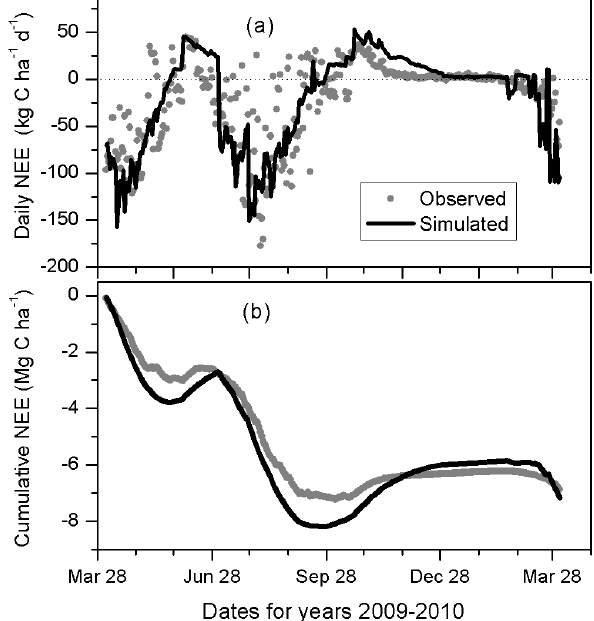
Fig. 2. Simulated and observed aboveground biomass (a) and grain yields (b) of the wheat–maize rotations. Aboveground biomass of wheat–maize rotation was for the WS treatment in 2008–2009 and the U treatment in 2009–2010, with the vertical bars indicating the standard errors of 3 replicates (unpublished data of the au- thors, which were weekly measured since winter reviving or sum- mer maize germination using the method described by Liu et al., 2011, 2012). Grain yields of individual crop season for all treat- ments described in Table 1, with horizontal bars indicating the stan- dard errors of 3 replicates, were cited from Liu et al. (2011, 2012, 2013). ∗∗ indicates a significance level of P < 0 . 01.